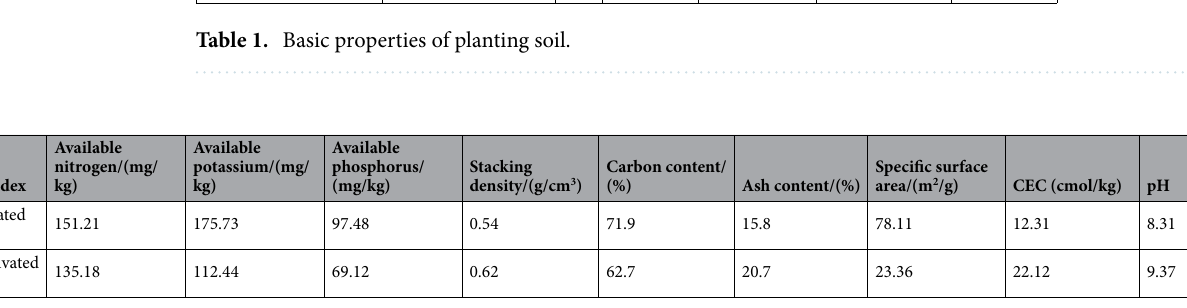
Table 2. Basic physicochemical properties of two types of activated